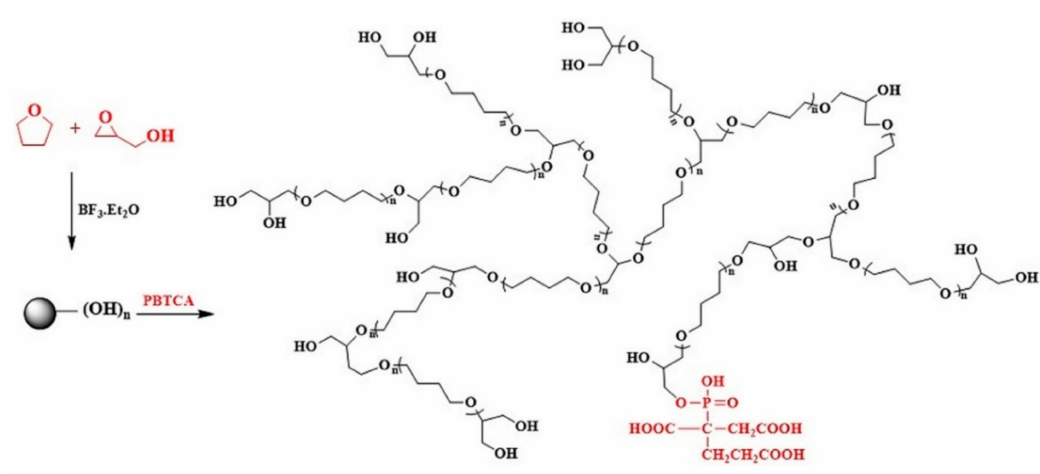
Figure 10. Synthesis approach of HBPs